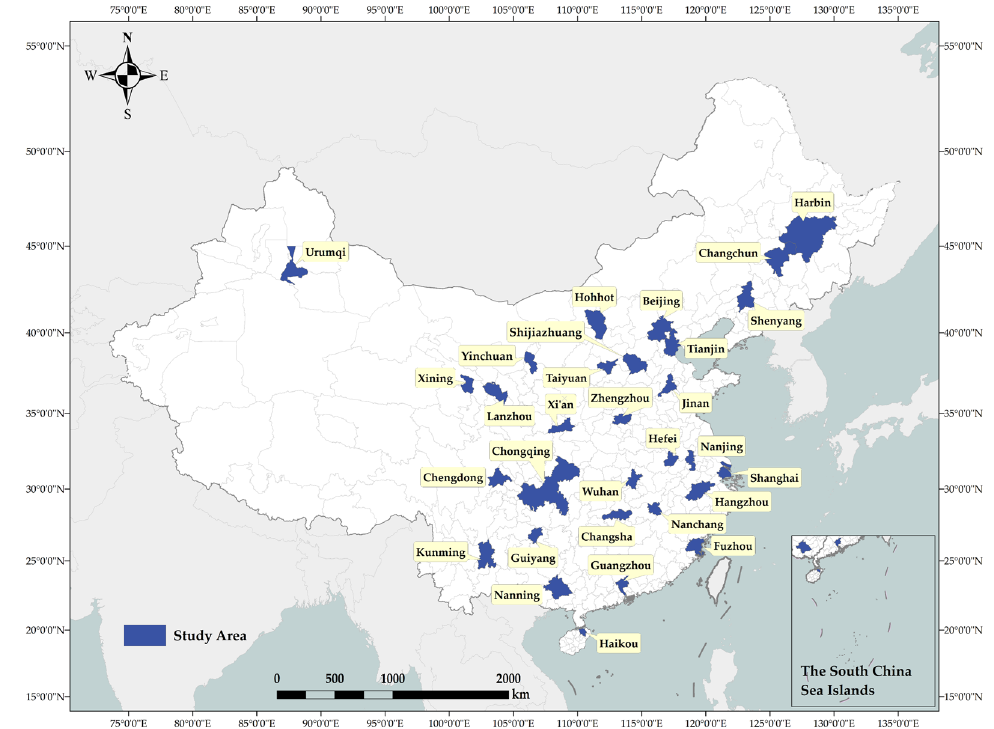
Figure 1. The geographic locations of 30 provincial capital cities of (our study area).